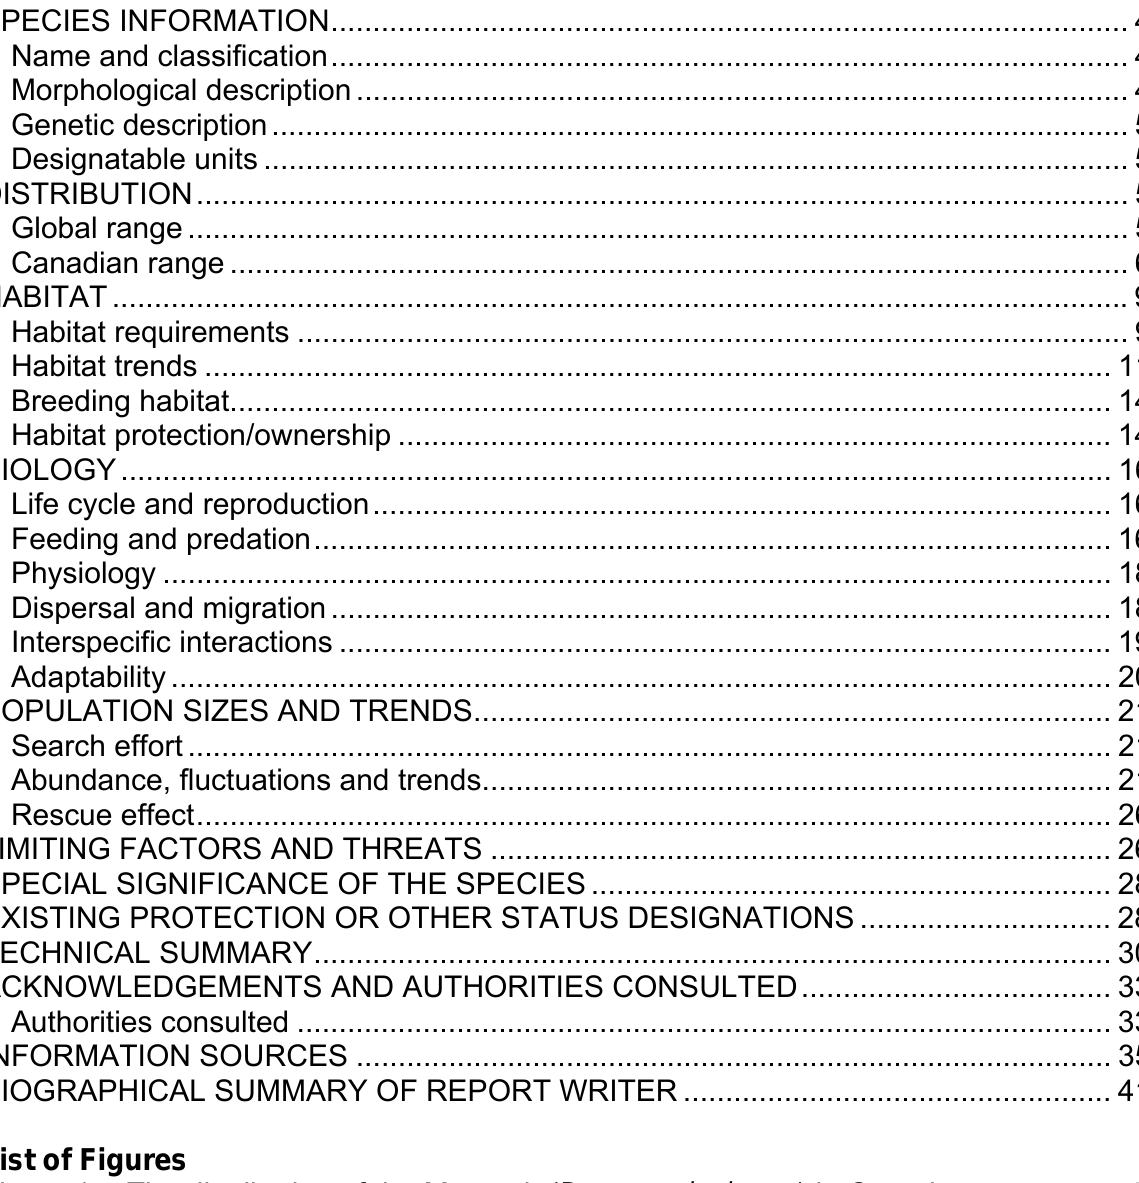
Figure 1. The distribution of the Monarch ( Danaus plexippus ) in Canada .................... 7 Figure 2. A. Fall migration of Monarch butterflies. B. Spring/summer migration of Figure 3. Aerial photographs of part of the core and buffer regions of a Monarch Preserve in Mexico in 2004 (top) and 2008 (bottom), showing loss of forest in the core area. The top figure also shows the locations of overwintering sites in different years and clearly indicates that these Figure 4. Changes in number of overwintering Monarch butterflies in